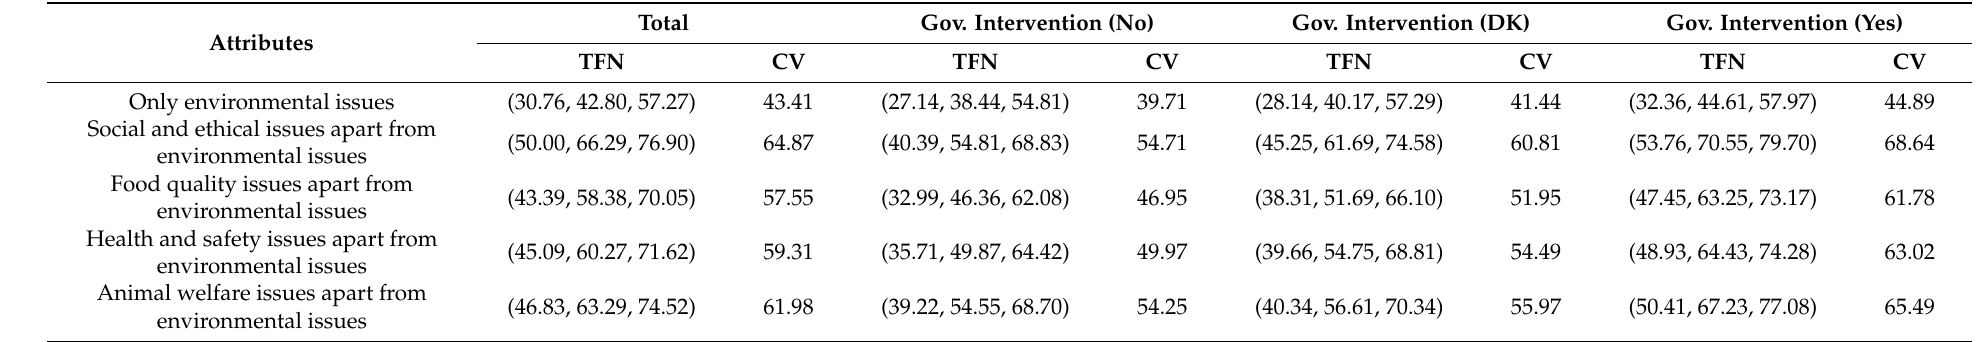
Table 4. Triangular fuzzy numbers (TFNs) and crisp values (CVs). Total and governmental intervention segments of analysis.